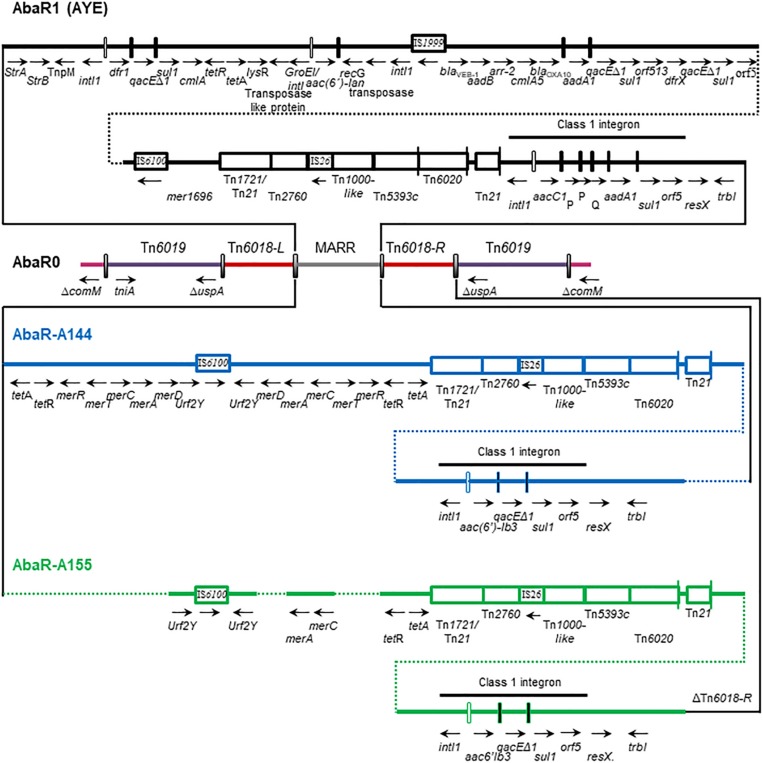
Representation of the AbaR0-like GI found in Acinetobacter baumannii AYE, A144 and A155 strains. The comM gene is interrupted by the insertion of the AbaR0-like GI. The region of multidrug resistance (MARR) is detailed, in this area we found variations in relation with the AbaR type GI previously reported.